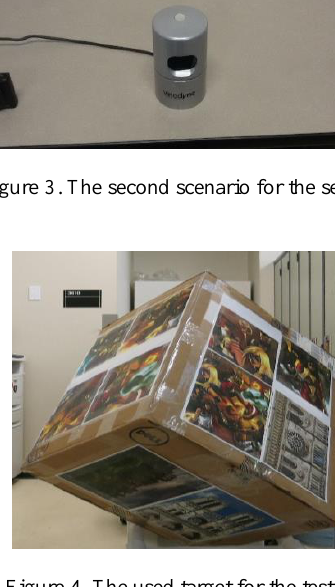
Figure 4. The used target for the